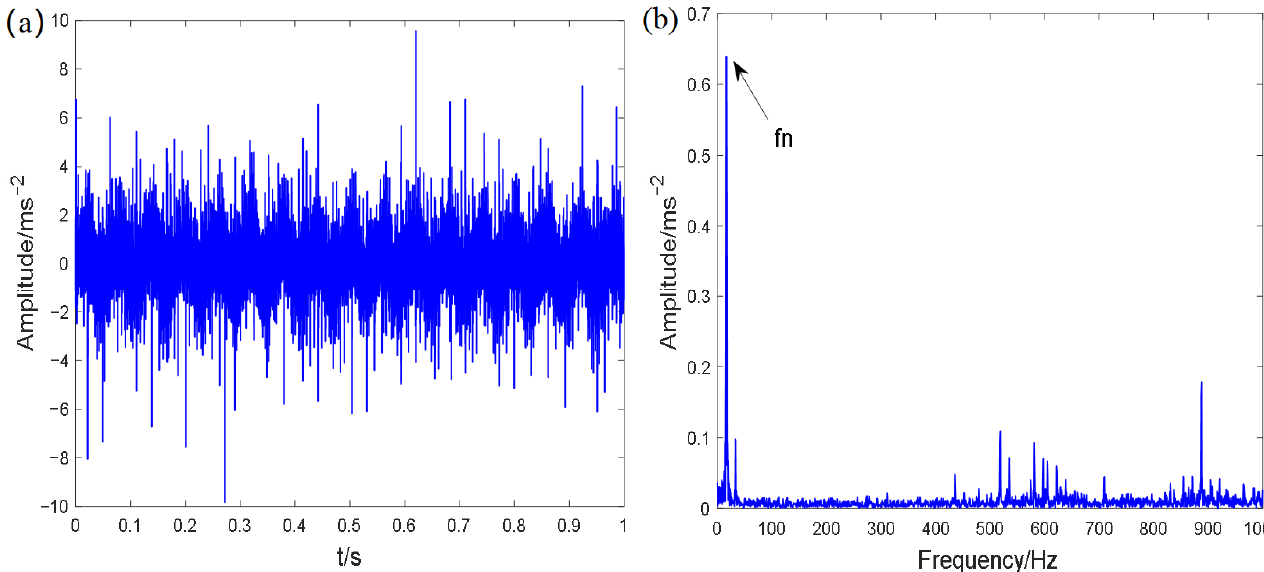
Figure 5. ( a ) original vibration signal and ( b ) frequency spectrum of vibrating screen bearing with inner ring fault. inner ring